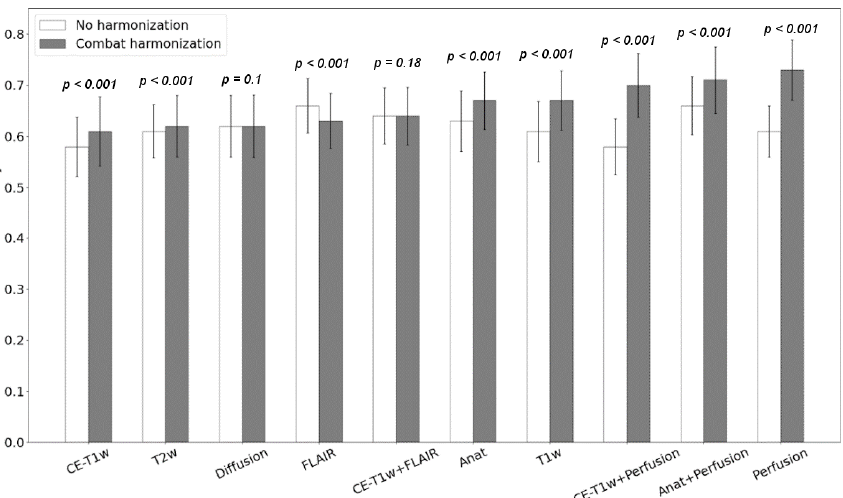
Figure 5. Classification accuracy obtained with the Logistic Regression model before (white) and after ComBat harmonization (gray). The p -values from the Wilcoxon test are shown for each pair. The x-axis refers to radiomics models based on features extracted from different combination of modalities. Anat refer to the radiomic model based on anatomical MR images (T1w, CE-T1w, T2w and FLAIR).